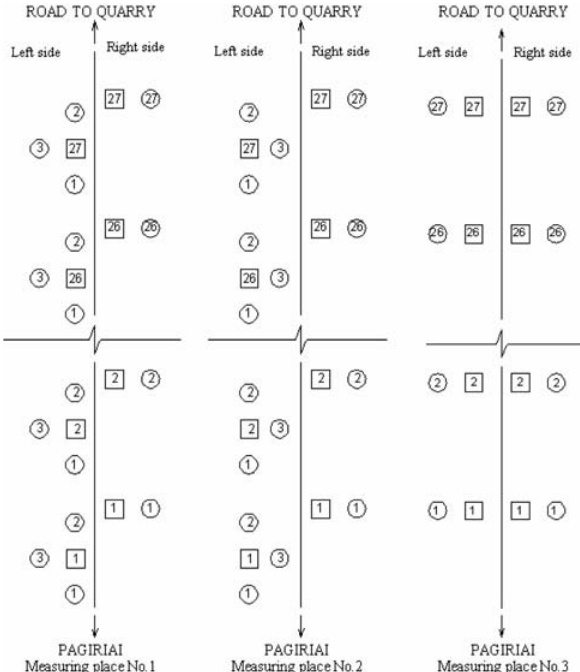
fig. 5. Measuring